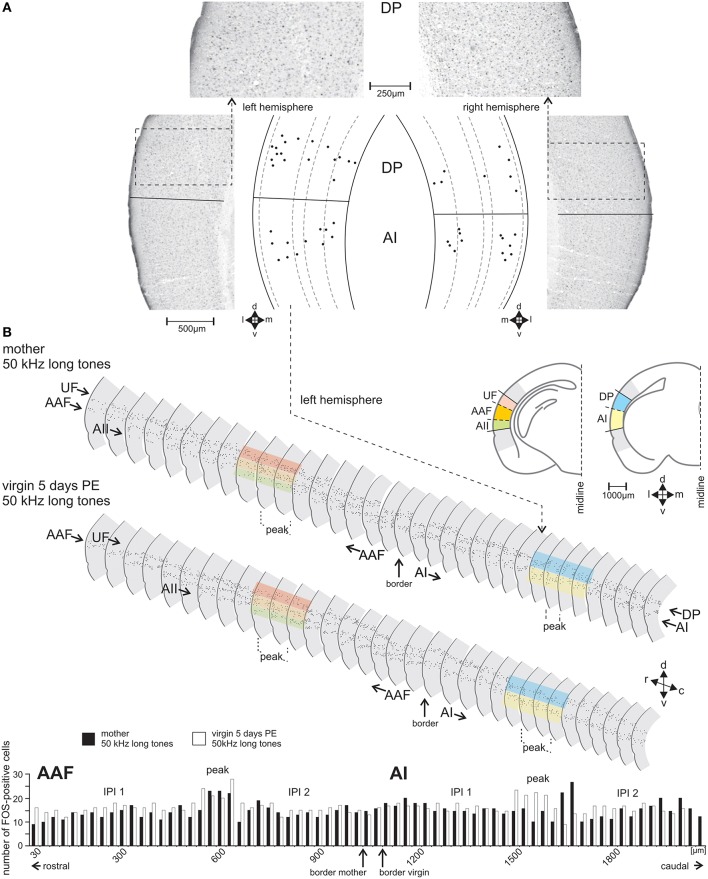
The FOS-positive cells identified and counted in serial sections through the AC. (A) Sample frontal sections through the left- and right-side AC of a group A mother in the area of the dorsoposterior (DP) and primary (AI) field with FOS-stained cells having nuclei in shades from black to gray. Cells counted as FOS-positive are indicated in the scale drawings as black dots at their positions relative to the cortical layers. (B) Scale drawings of the left-side AC of a group A mother and a group C virgin assembled in a serial reconstruction of the AC. Only every second section is shown. FOS-positive cells are indicated by dots. The colored bands over some sections show examples where the dorsoventral borders between the fields occurred. The histogram shows the numbers of FOS-positive cells in each section of AAF (anterior field) and AI of the mother (black bars) and the virgin (white bars). In the middle of both AI and AAF a peak in the number of FOS-positive cells (definition, see text) is visible with numbers higher than those in the inter-peak intervals (IPI 1, IPI 2) rostral and caudal of each peak. In the fields UF (ultrasonic field), AII (secondary field), and DP (dorsoposterior field) no peak areas occurred. c, caudal; d, dorsal; r, rostral; v, ventral.